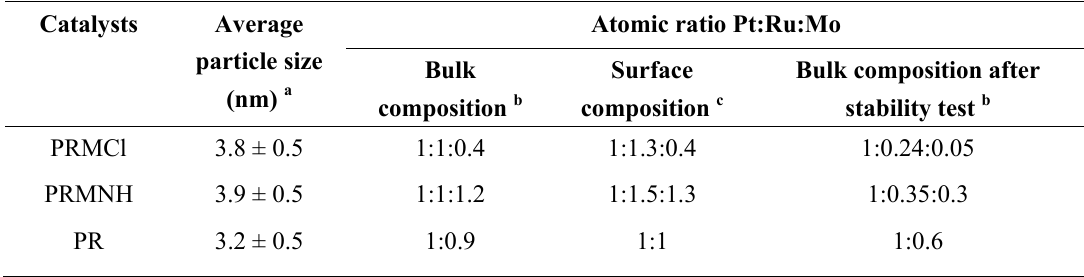
Table 1. Effect of Mo precursor. Structural parameters of the